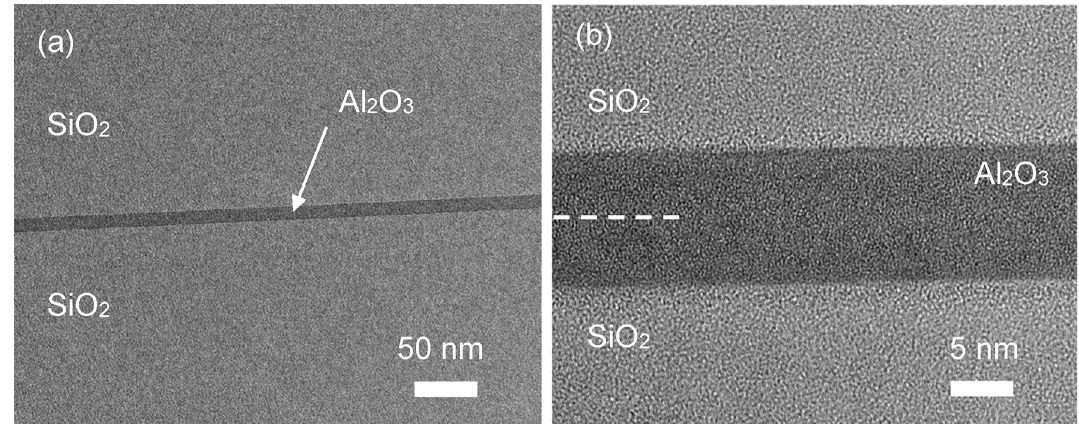
Figure 4. ( a ) Low- and ( b ) high-magnification cross-sectional TEM images of the bonding